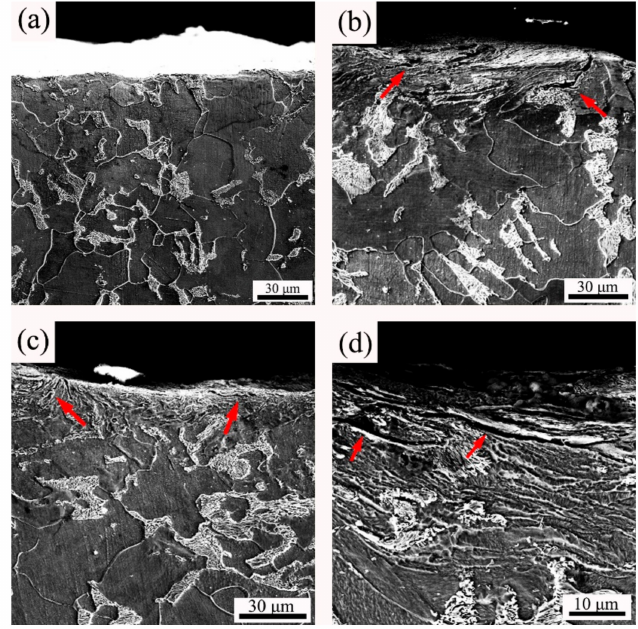
Figure 4. SEM images of the RASP-processed samples: ( a ) 5 min, ( b ) 10 min, ( c ) 15 min, ( d ) 20